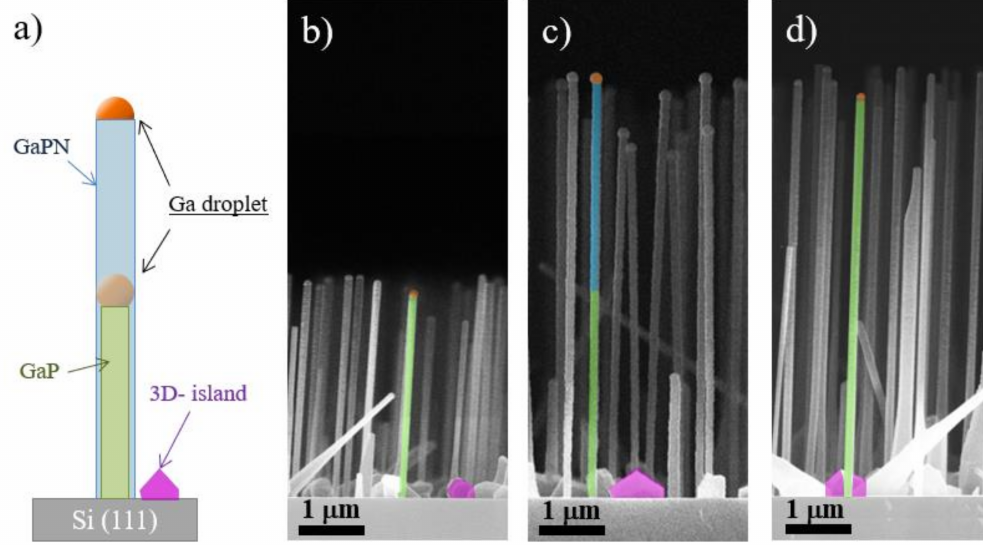
Figure 2. ( a ) Schematic representation of the NW geometries. Cross-sectional view SEM images of: ( b ) GaP stems, ( c ) heterostructured GaPN / GaP NWs, and ( d ) GaP NW array (reference